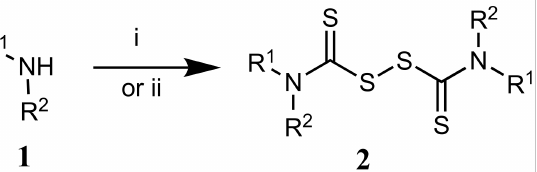
Figure 1. Chemical synthesis of disulfiram analogue 2 . i: CS 2 , CB 4 , DMF, RT. ii: NaOH, CS 2 , NaNO 2 , water, 0 ◦